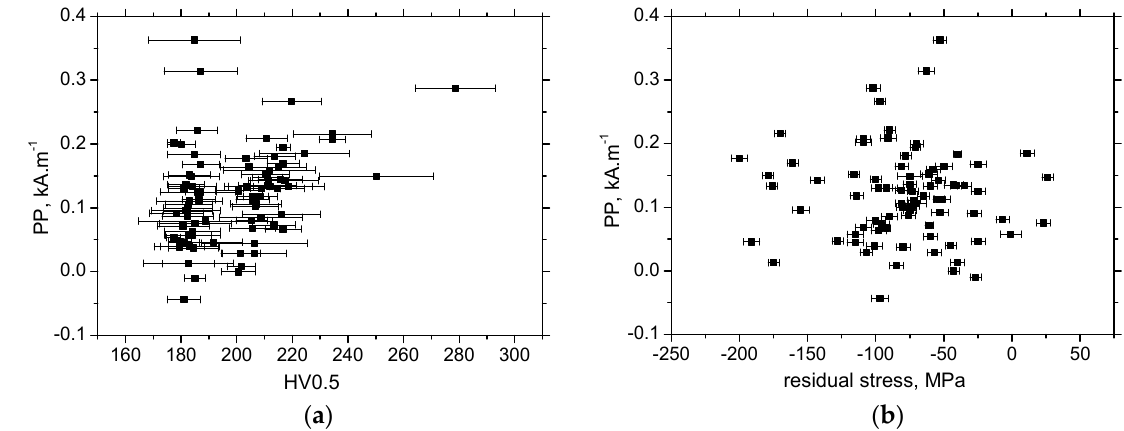
Figure 23. Correlations for PP , TD. ( a ) PP versus HV0.5; ( b ) PP versus residual stresses.